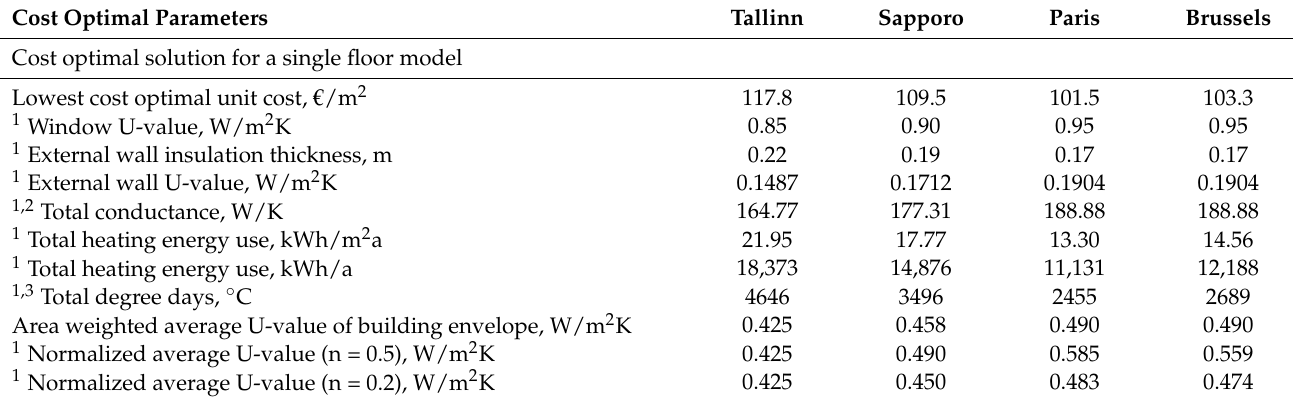
Table 4. Wall and window ‘U-value’ corresponding to the lowest cost-optimal solutions (based on investment and operational heating cost) for different climates.